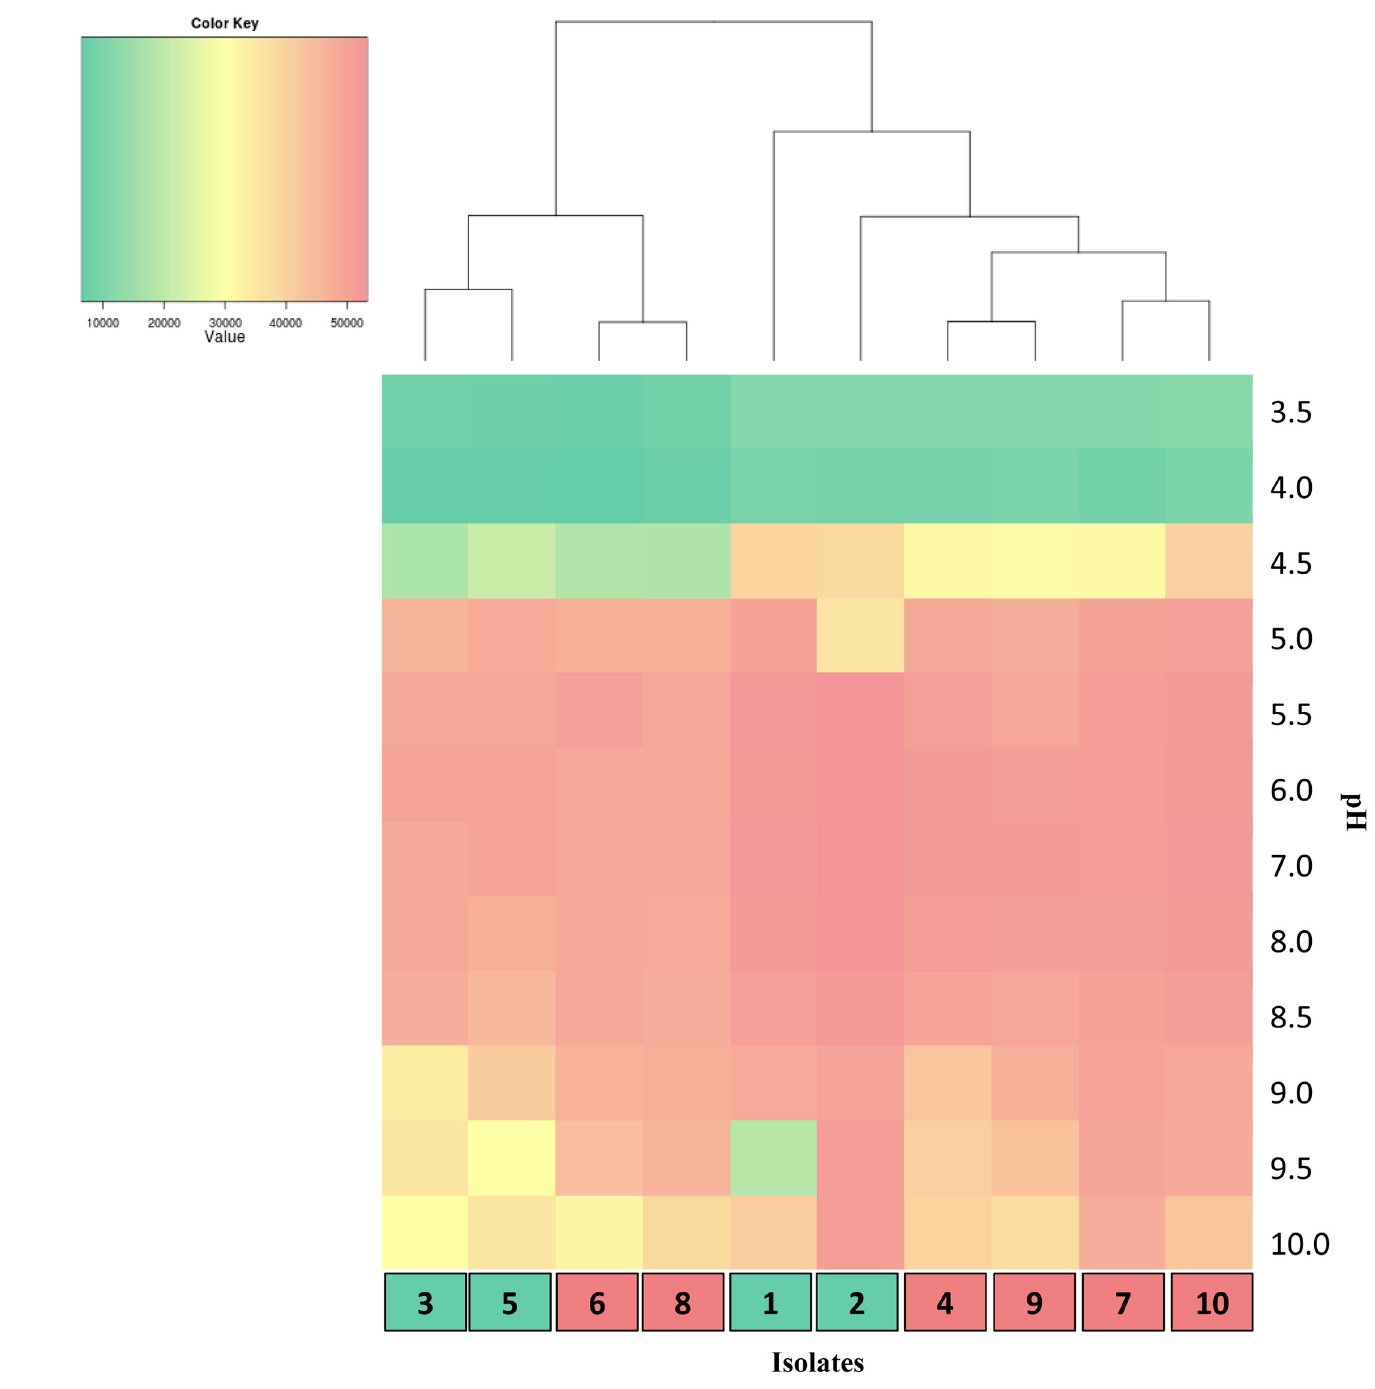
Fig 5. Growth of isolates over a pH range from 3.5 – 10. Isolates were grown for 48 h at various pH ranging from 3.5 to 10. The colour key represents relative growth based on oxidative activity using area under the curve (Omnilog units). Isolates are identified in pink (super-shedders) and teal (low-shedders) boxes as in Fig